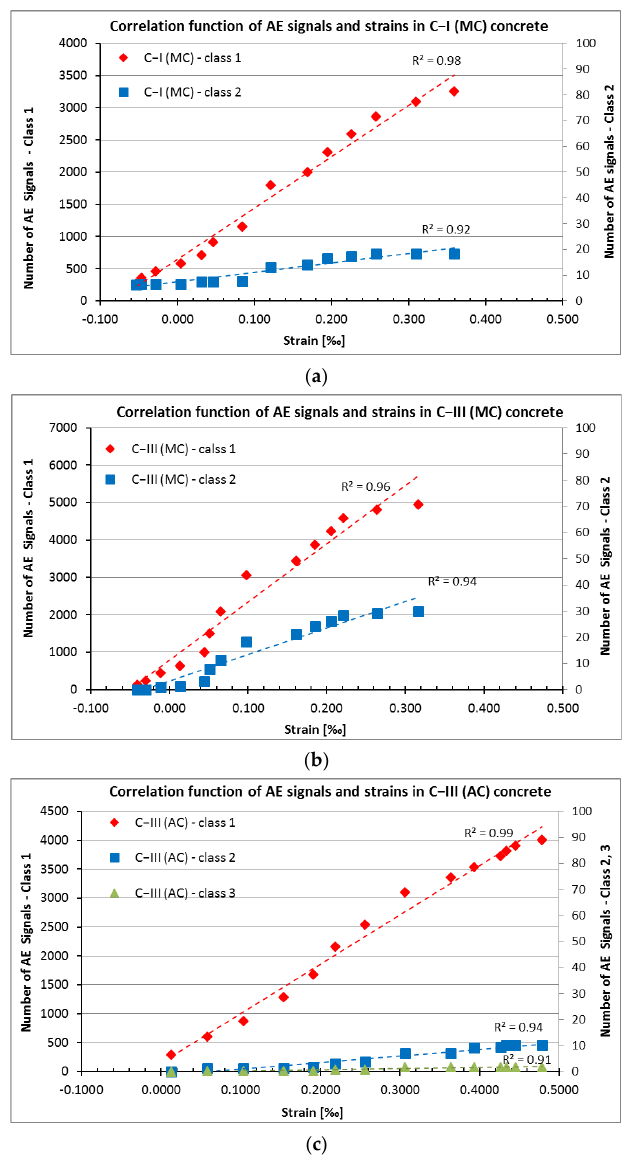
Figure 9. Correlation functions of AE signals and strains for the C − I (MC) ( a ) and C − III (MC) concrete series (subjected to curing) ( b ) and C − III (AC) (without curing) ( c ). In the presented graphs on the horizontal axis, the values of shrinkage strains are shown, while the vertical axes show the number of class 1 signals on the left axis, and the number of class 2 and 3 signals on the right axis. The use of two vertical axes is due to significant differences between the quantities of class 1, 2, and 3 signals. Presenting them on one axis would make their analysis impossible. However, if class 3 signals were not recorded in a sample, no additional vertical axis was added.